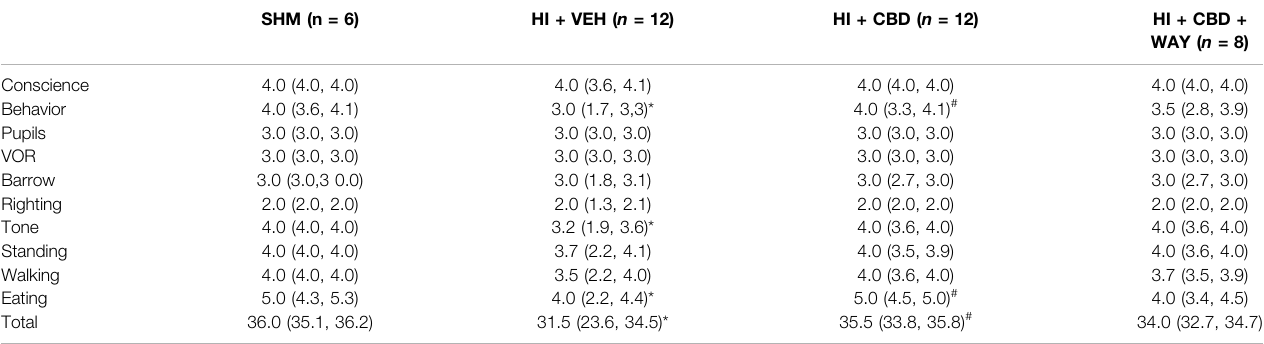
TABLE 2 | Neurobehavioral